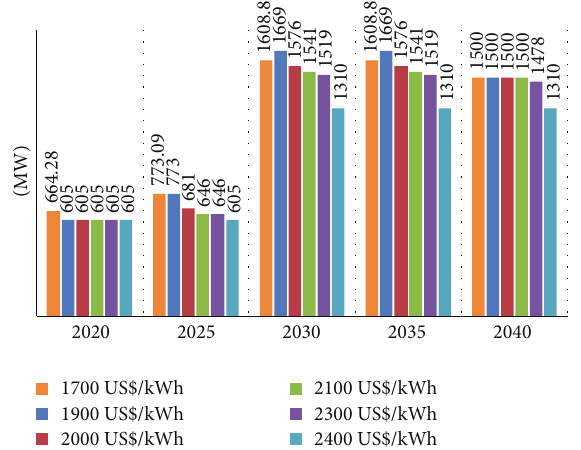
Figure 7: The installed capacity shares changes for coal power plants.